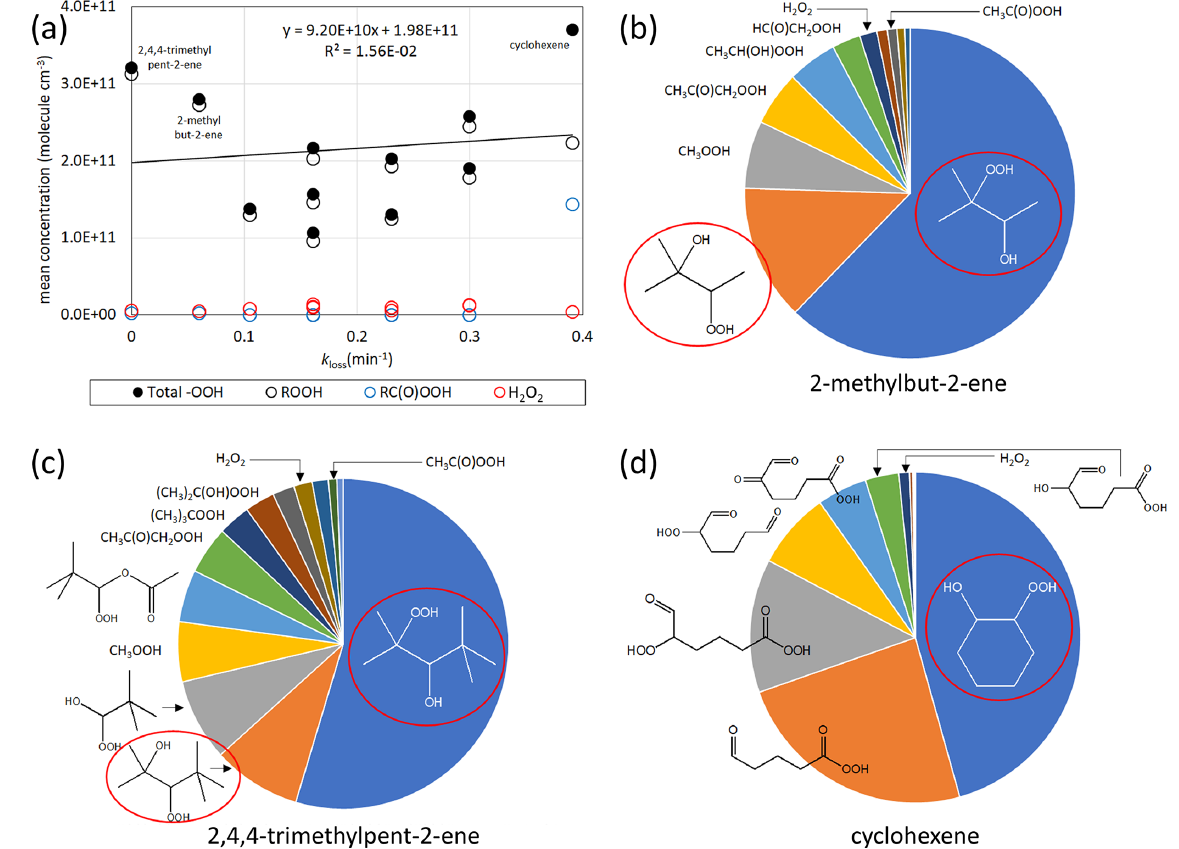
Figure 2. (a) Simulated concentrations of hydroperoxide products vs. k loss for E. coli in 33ppb O 3 experiments for the series of 11 alkenes shown in Fig. 1, showing the concentrations for H 2 O 2 , ROOH species and RC(O)OOH species and their totals (total − OOH), as well as linear regression of the total − OOH data. (b–d) Simulated speciation of peroxidic compounds generated from 2-methylbut-2-ene, 2,4,4- trimethylpent-2-ene and cyclohexene in the 33ppb O 3 experiments. The total − OOH concentrations in the three cases were 2 . 8 × 10 11 3 . 2 × 10 11 and 3 . 7 × 10 11 moleculecm − 3 , respectively. Species in red ellipses are those formed from the HO + alkene